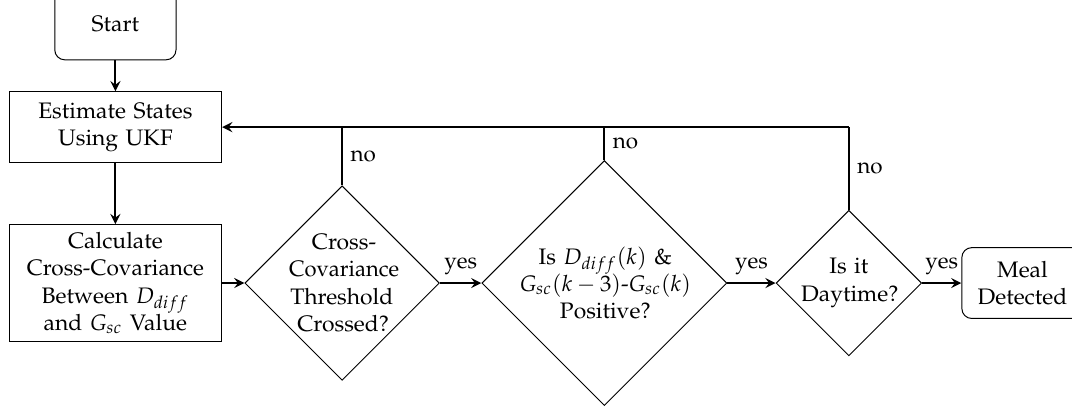
Figure 2. Flow chart of the meal detection algorithm. First, the states of a minimal model are estimated using an Unscented Kalman filter (UKF) and then the cross-covariance is found between the state estimation for the forward difference of the disturbance parameter ( D dif f ) and the glucose value G sc obtained from a continuous glucose monitor (CGM). A threshold is applied to the cross-covariance, and, once crossed, the last unscaled value of D dif f and the slope with respect to the measurement 15 min ago (3 samples) of G sc are checked, if both are positive and it is daytime, a meal is